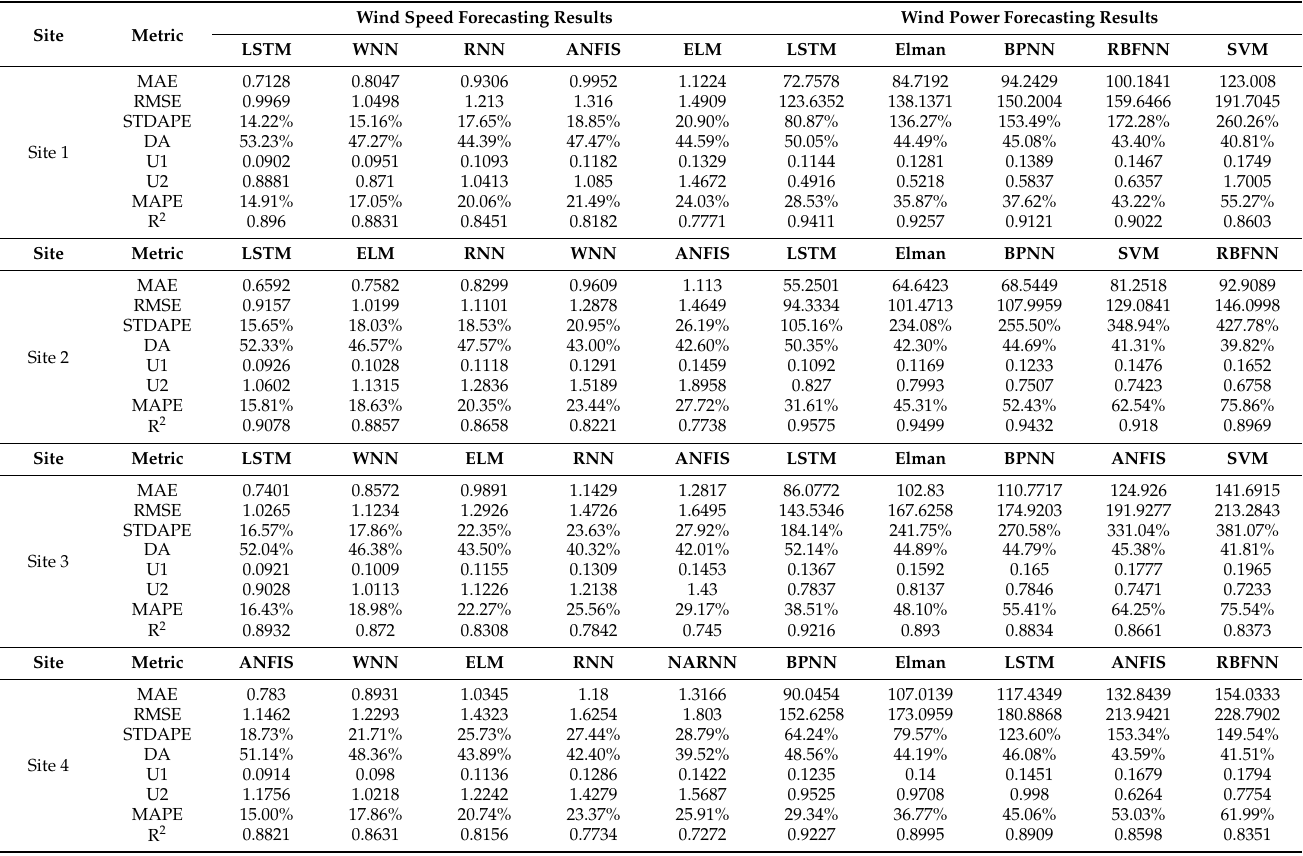
Table A2. The forecasting performance of five optimal sub-models for wind speed and wind power in the second season. Site